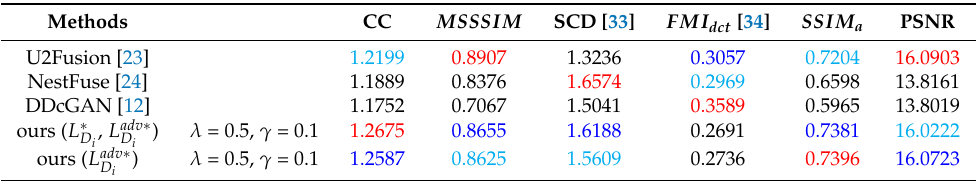
Figure 3. Qualitative comparison of the proposed method with other state-of-the-art methods on image pairs taken from the RoadScene dataset. The first row contains visible images. Second row contains infrared images. The last row contains the fused results of our proposed method. Table 1. The average values of quality metrics for 20 fused images of our RoadScene dataset with λ = 0.5 and γ = 0.1 used in the loss function. The best values are indicated in red, the second best values are indicated in blue and the third highest values in